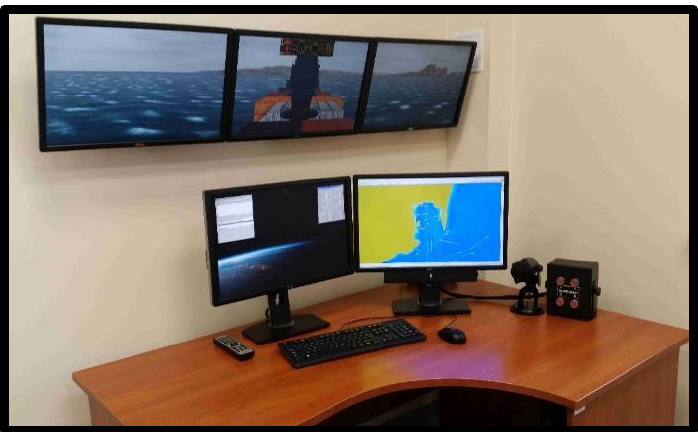
Figure 1. Schematic plan of the simulator components and navigation bridge layout. Source: Own elaboration based on a project prepared by Kongsberg.